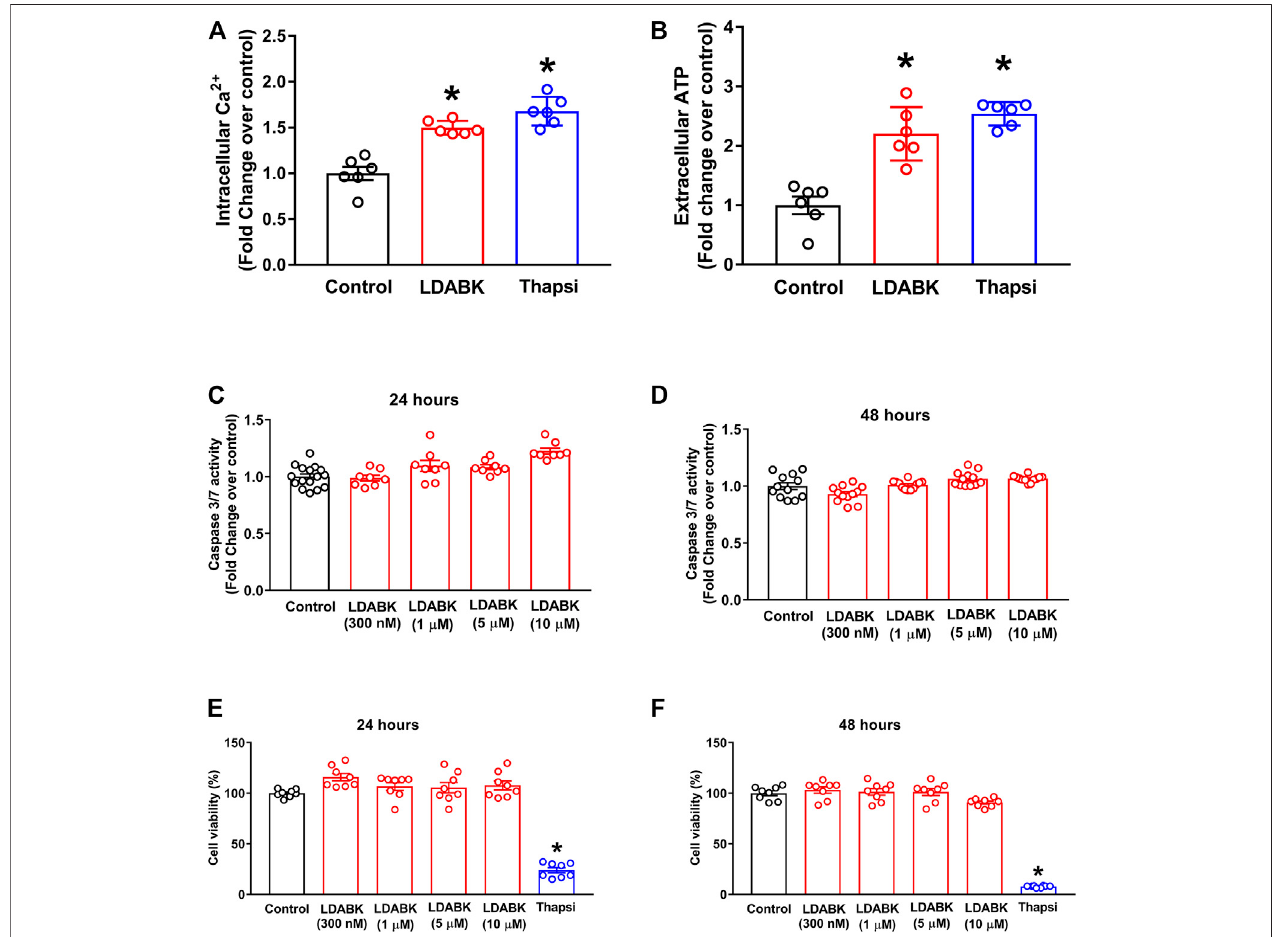
FIGURE 4 | B1R activation increases Ca 2+ and ATP depletion but does not induce cell death in primary hypothalamic neurons. LDABK (300 nM) stimulation induces an increase in intracellular Ca 2+ after 1 h (A) and extracellular ATP levels after 24 h (B) , indicating depletion of Ca 2+ and ATP in neurons upon activation of